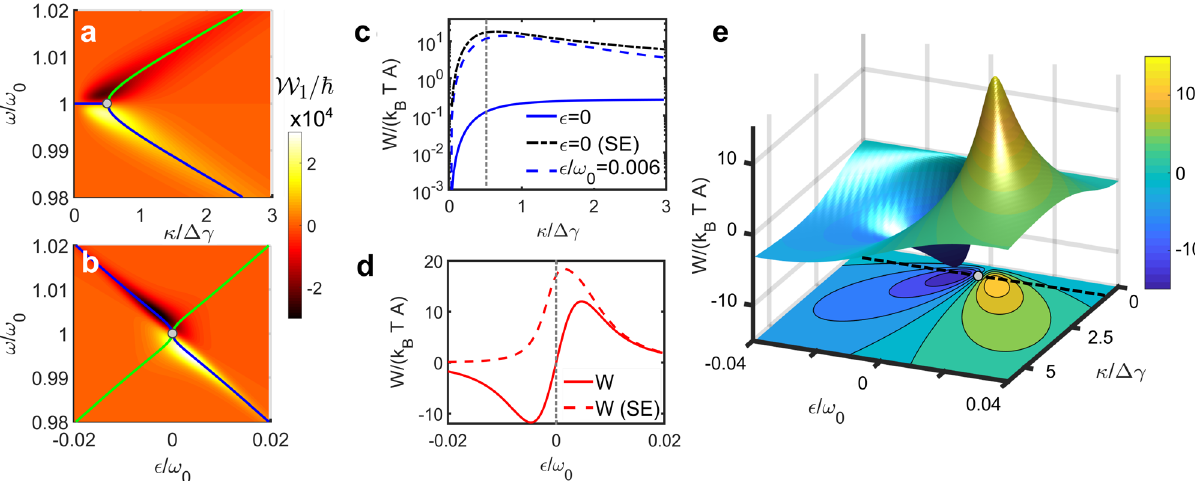
Fig. 2 Work in the proximity of an exceptional point (EP). Work density (color scale) as a function of the frequency ω of the incident radiation and the coupling constant κ ( a ) and resonance detuning ϵ ( b ). Blue and green solid lines are the eigenfrequencies of H eff. , which demonstrate an EP degeneracy (gray dot) at κ = κ EP = 0.5 Δ γ ( Δ γ is the differential loss) in a (where ϵ = 0) and at ϵ = 0 in b (where κ = κ EP ). c The work W for ϵ = 0 ( ϵ = 0.006 ω 0 ) is indicated with a blue solid (dashed) line. We also report the work in the case where we have introduced spectrally engineered (SE) reservoirs (black short- dashed line) via the spectral fi ltering function Φ ( ω ) = H ( ω − ω 0 ) ( H ( x ) is the Heaviside function). d Work with SE reservoirs for ϵ = 0 (red solid line) and ϵ ≈ 0.006 ω κ = κ ϵ = 0, respectively. e We report the 0 (red dashed line). In ( c , d ), the vertical dashed gray lines indicate the position of the EP at EP and total work W as a function of κ and ϵ . The EP is indicated with a gray dot (the black dashed line indicates the value of κ EP ). In the vicinity of EP, the work becomes extreme (positive or negative). In these calculations, the average resonance frequency is ω 0 = 200 × 10 12 rad s − 1 , the temperature of the hot (cold) bath is T H = 10 9 K ( T C = 3 K), and the decay rates of the two modes are γ 1 = 0.01 ω 0 and γ 2 = 0.002 ω 0 . In c – e , T = ( T H + T C )/2 is the average temperature of the reservoirs, A is the area in the parameter space, and k B is the Boltzmann